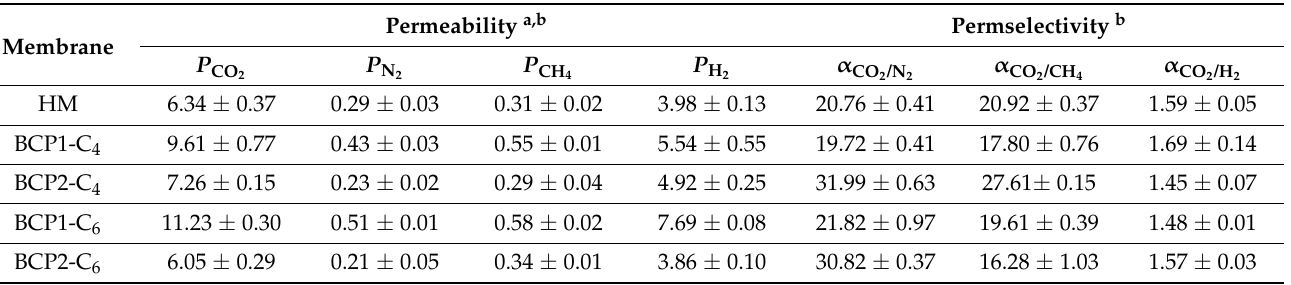
Table 2. Pure gas permeabilities and permselectivities of p ([NBM-mIm][Tf 2 N]) and BCPs measured at 2 atm and 20 ◦